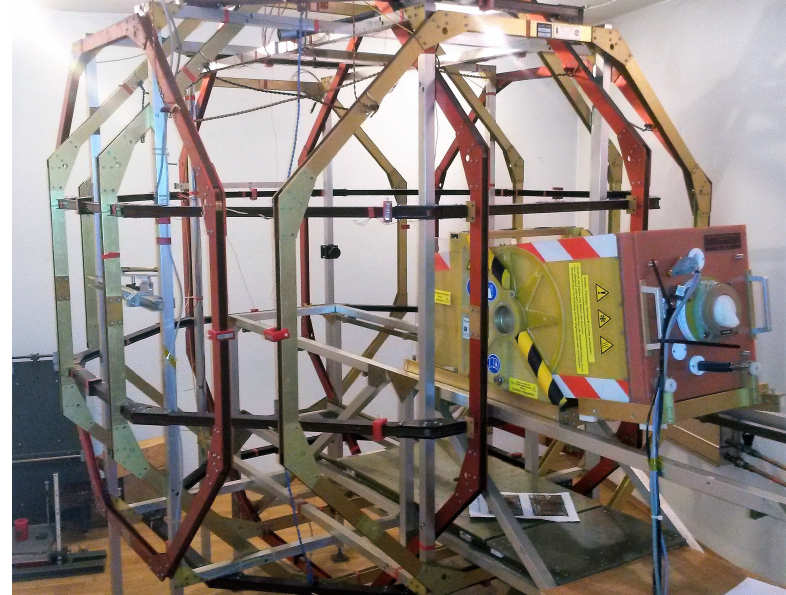
Figure 1. Braunbek coil system of the Magnetsrode calibration facility. The sensor under test is placed inside the yellow measurement box, which is then pushed into the middle of the coil system and set upright for the